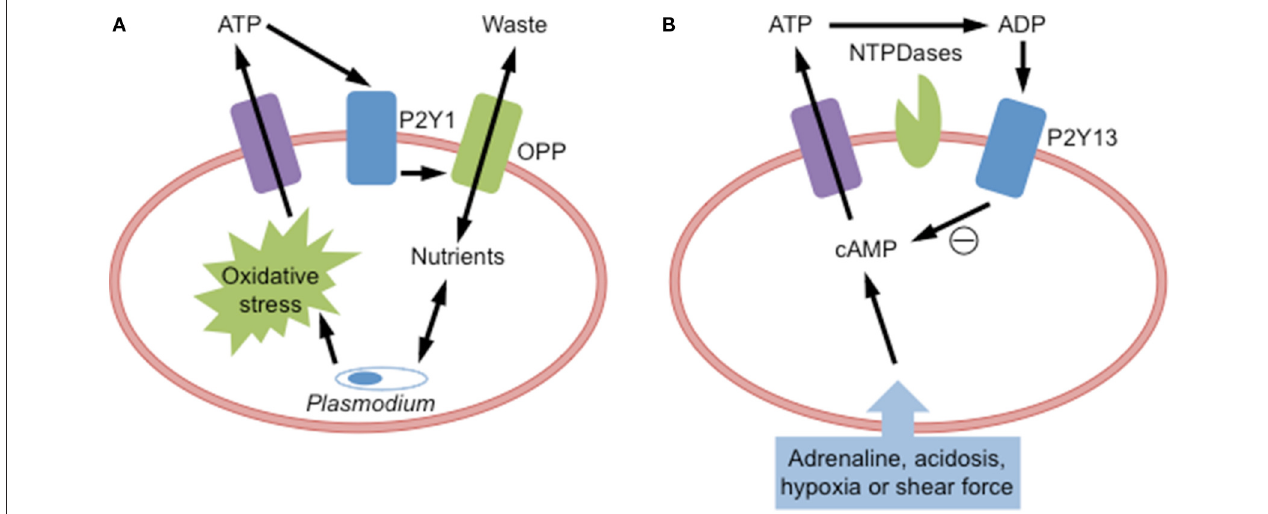
FIGURE 2 | P2Y receptor activation in red blood cells. (A) Plasmodium malarial parasite infection of red blood cells causes oxidative stress to induce adenosine triphosphate (ATP) release, which activates P2Y1 receptors to open an osmolyte permeability pathway (OPP) to facilitate parasite growth by supplying incoming nutrients and removing outgoing metabolic waste products. (B) Cellular stress (acidosis, adrenaline, hypoxia, or shear force) of red blood cells increases intracellular cyclic adenosine monophosphate (cAMP) to cause ATP release. Released ATP can be degraded by ectonucleotidases (NTPDases) to adenosine diphosphate (ADP), which then activates P2Y13 receptors to reduce cAMP and prevent further ATP